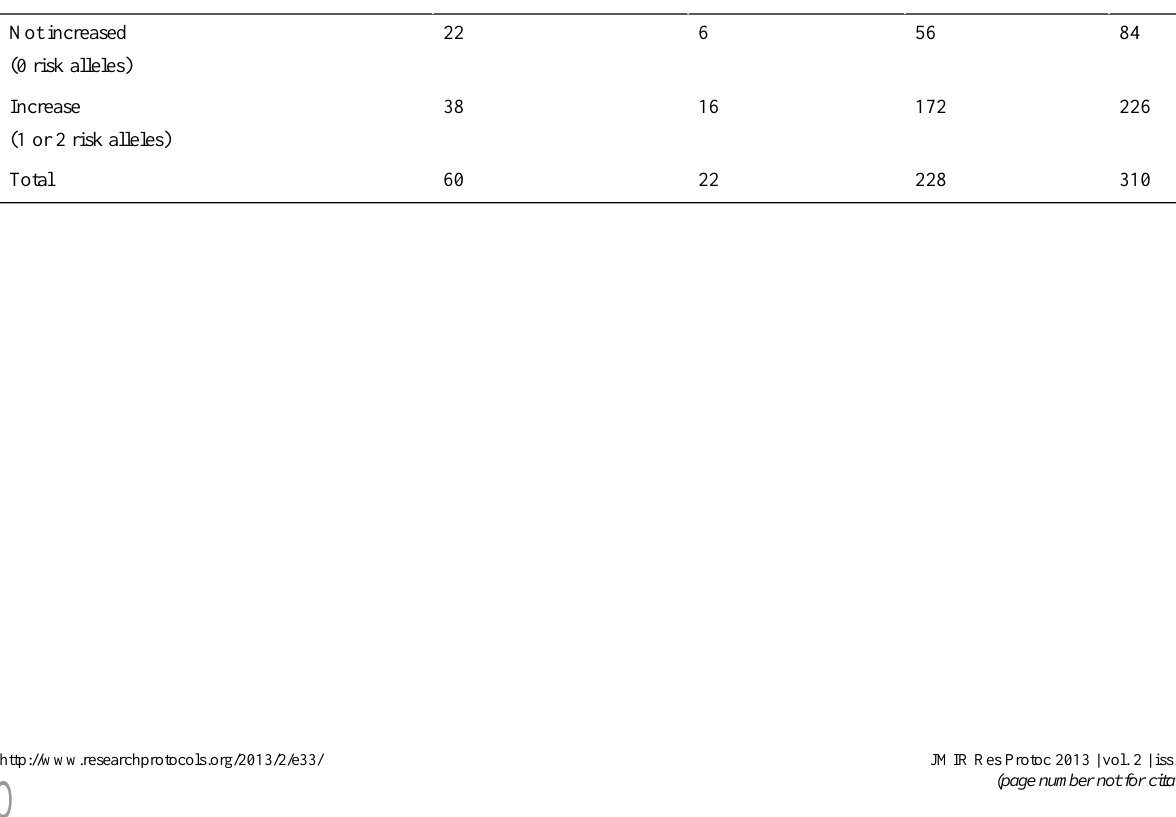
Genetic risk category recall at follow-upActual GRS score category at